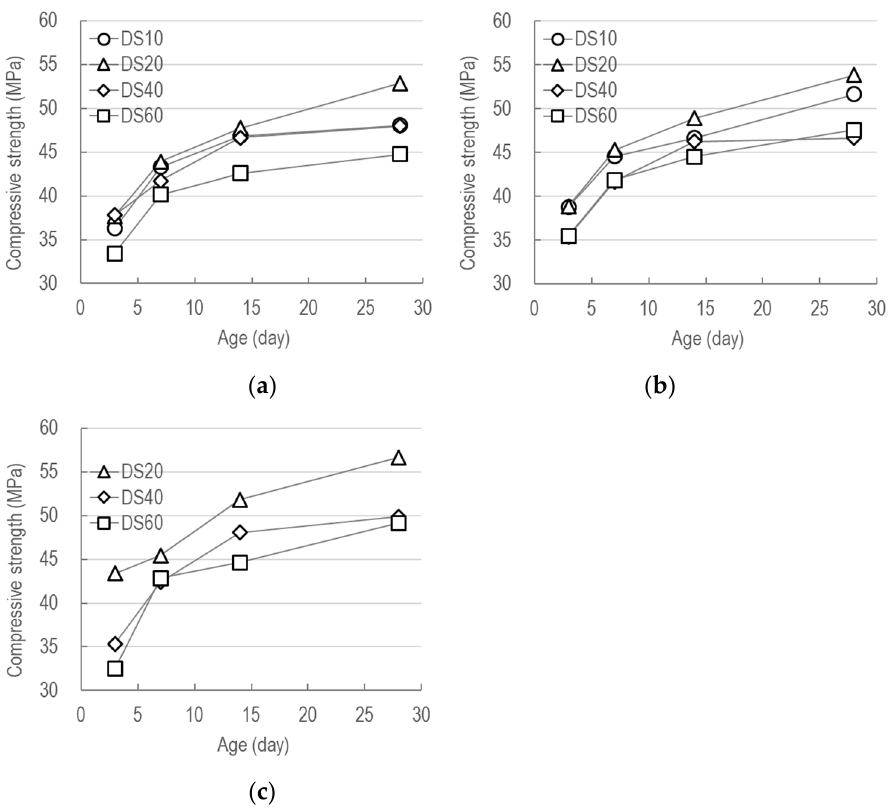
Figure 6. Compressive strengths of the different concrete mixtures according to age; ( a ) W170, ( b ) W160, and ( c ) W150.